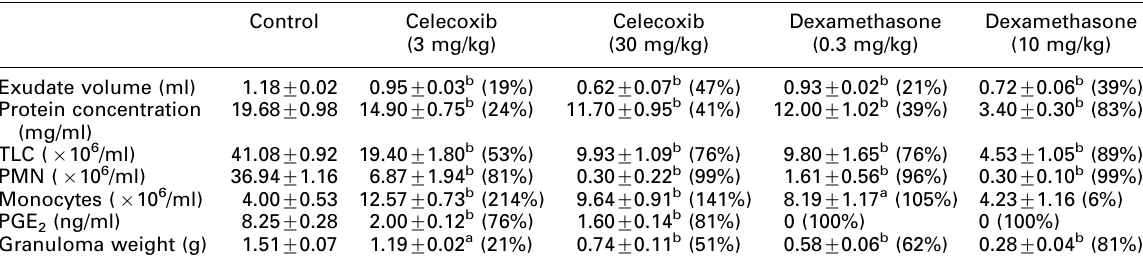
Table 1. Anti-inflammatory effect of drugs administered orally 1 h before injecting DL into the air-pouch cavity Control Celecoxib (3 mg/kg)